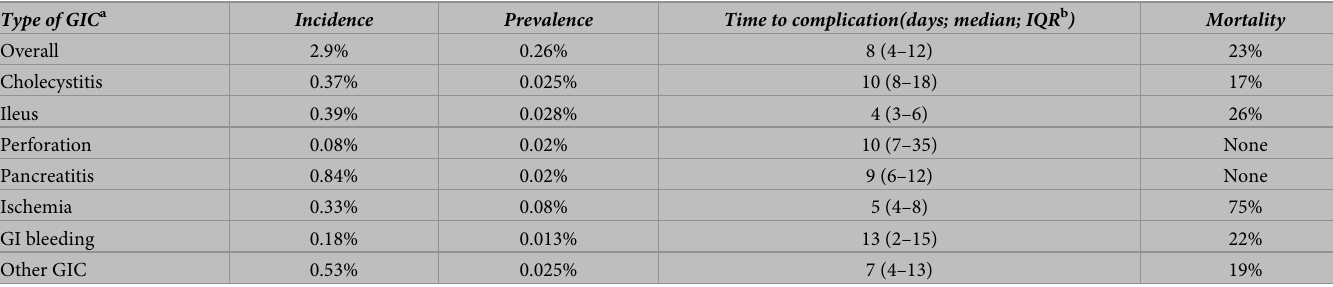
mortality are presented in Tables 1 and 2; treatment and outcome details of patients with GIC are presented in Fig 2.